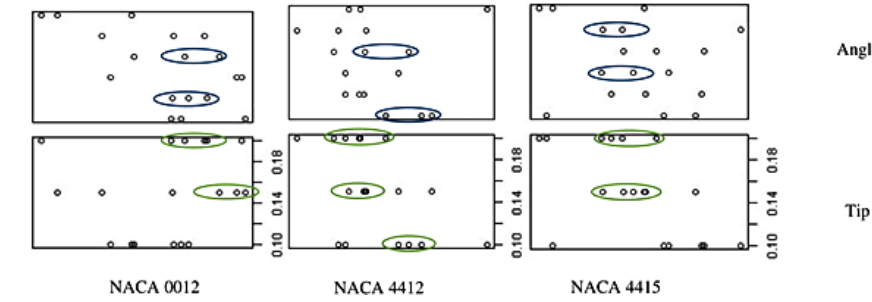
Figure 23. Scatter plot for blade angle and blade tip size of airfoils NACA 0012, NACA 4412, and NACA